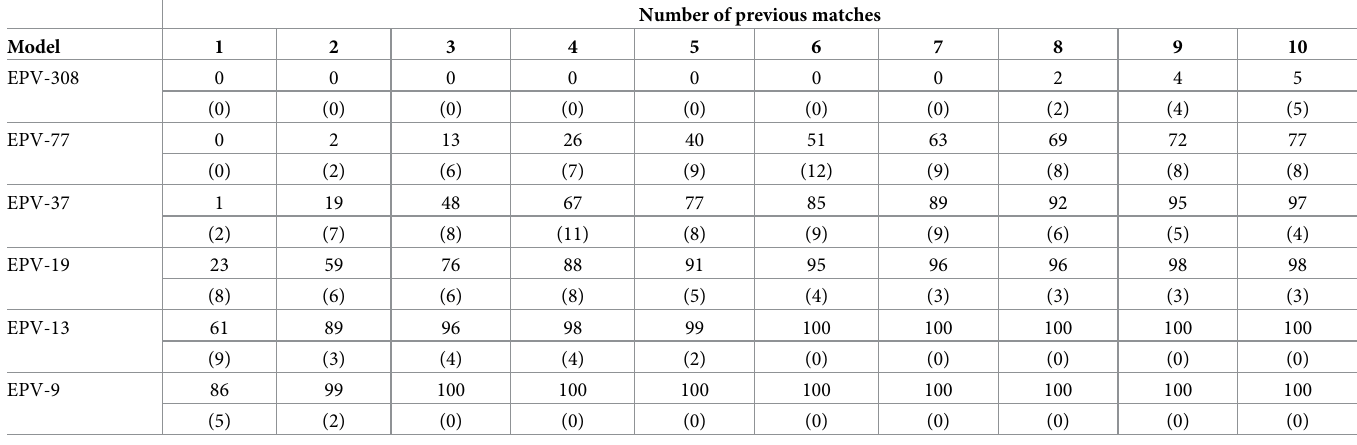
Table 2. Percentage of non-infinity zones for each model, providing the percentage of matches where the complete set of the subsequent match’s zones were visited in the previous n matches. Values are mean (standard deviation) percentage (%) across all clubs.